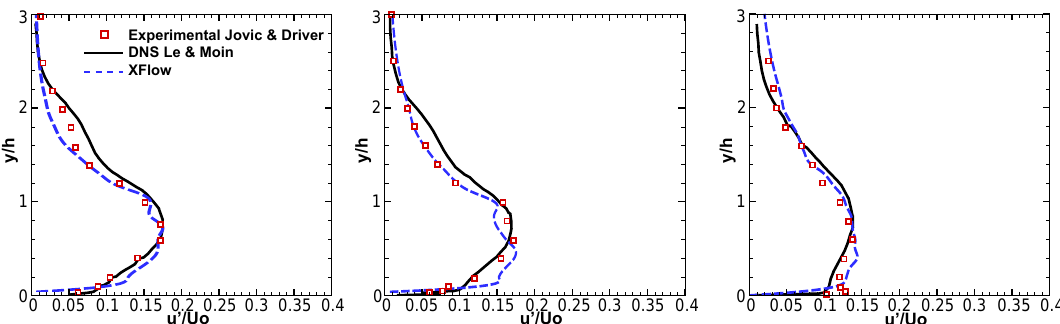
Figure 7. Standard deviation x-velocity profile for numerical and experimetal results at different longitudinal sections: X / h = 4 ( left ), 6 ( middle ) and 10 ( right ).